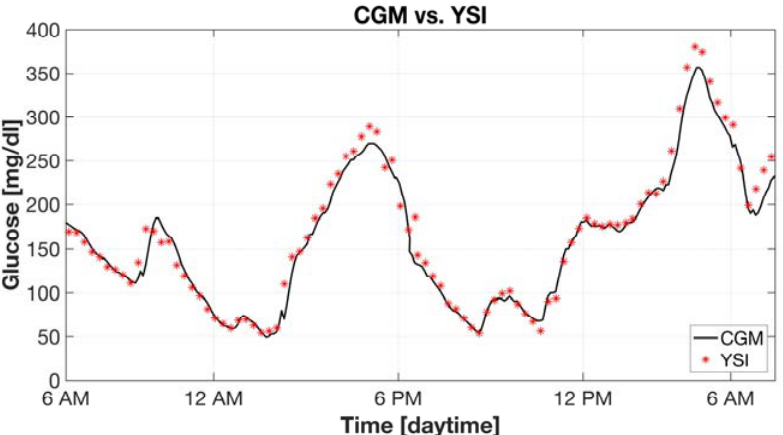
Figure 3. Example of YSI measurements (red stars) versus Dexcom G4 Platinum CGM (black solid line) measurements, collected during a monitoring of a T1D patient made for about 1 day within a hospital. By using YSI data as ground truth, accuracy of the sensor can be quantified e.g., by computing the mean absolute relative difference (MARD) as the average of the ratio between the absolute difference between the CGM measurement and the YSI over the YSI.